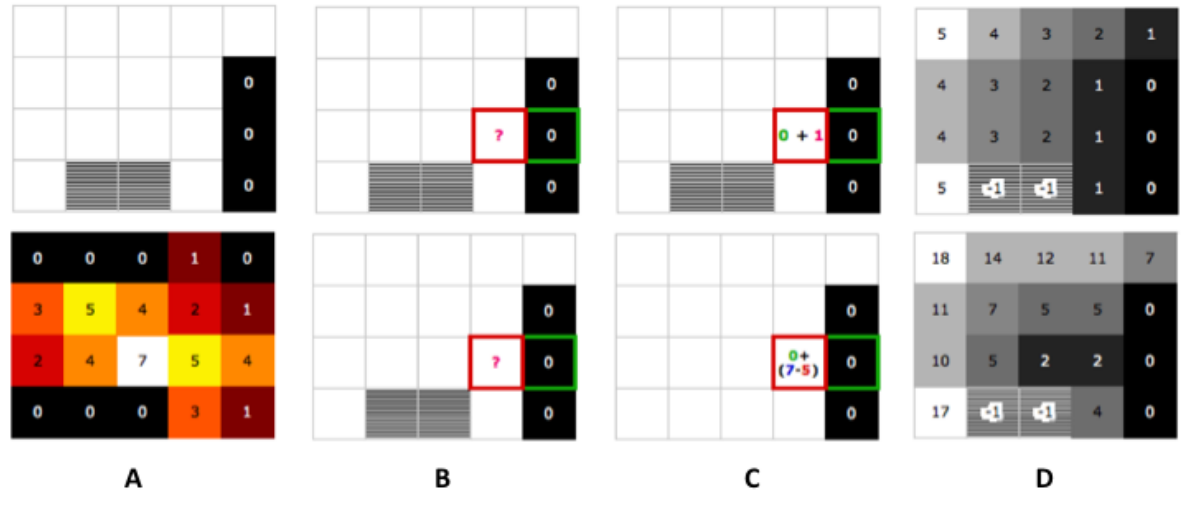
Figure 5. Constructing the gradient for the distance-based ( top ) and the activity-based heat map ( bottom ) informed